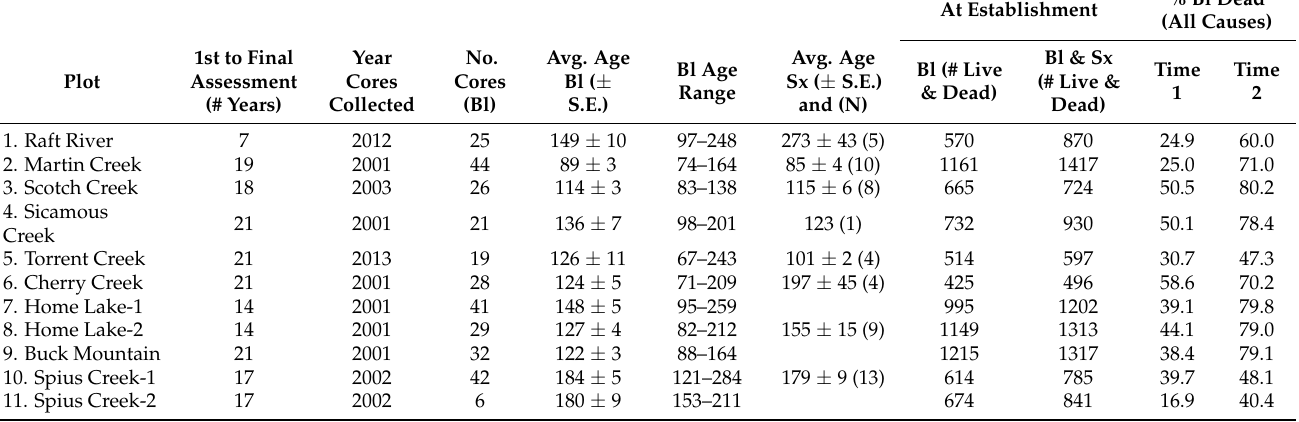
Table 3. Average age ( ± standard error) (S.E.) of subalpine fir (Bl) and spruce (Sx) (corrected to 2020) in 11 plots; total number of subalpine fir and spruce (live and dead) at establishment (Time 1); and percent dead subalpine fir at Time 1 (plot establishment) and Time 2 (final